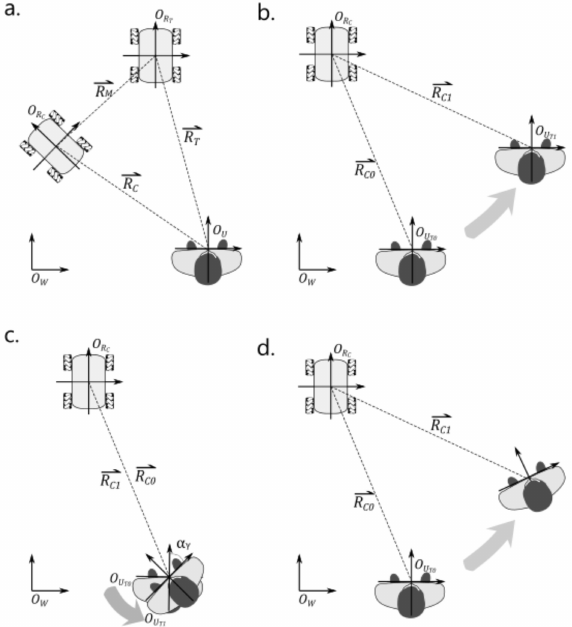
Figure 1. The movements of the accompanying robot and the user. ( a ) the robot translates and rotates to the target position; ( b ) the user translates without rotation; ( c ) the user rotates in place without translation; ( d ) the user translates and